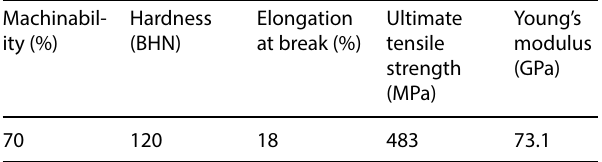
Table 2 Mechanical properties of AA2024 [30]